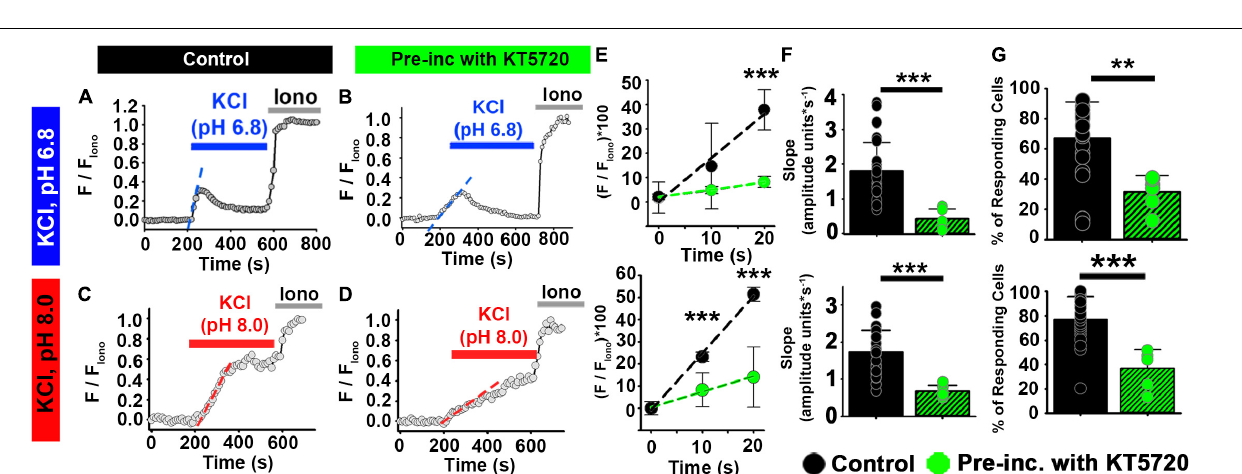
FIGURE 5 | PKA inhibition impairs the effect of HCO 3 − on depolarization-evoked Ca 2 + responses in ejaculated mouse sperm. (A–D) Representative traces of [Ca 2 + ] i responses to 50 mM KCl at pH 7.4 and pH 8.6 in ejaculated mouse sperm in (A,C) control conditions and (B,D) after pre-incubation with 10 µ M PKI. (E) Linear fit of the averaged normalized fluorescence in the first 20 s after KCl addition. (F) Graph of slope values of the best-fit regression line for each condition. Mean values at pH 7.4 were as follows: control, 2.20 ± 0.494 amplitude units * s − 1 (5 mice, 137 sperm); and PKI pre-incubation, 0.237 ± 0.144 amplitude units *s − 1 (4 mice, 86 sperm). Mean values at pH 8.6 were as follows: control, 2.45 ± 1.161 amplitude units * s − 1 (5 mice, 107 sperm); and PKI pre-incubation, 0.753 ± 0.232 amplitude units *s − 1 (3 mice, 81 sperm). (G) Graph of the percentage of responsive sperm. Mean values at pH 7.4 were as follows: control, 41.92% ± 10.22 (5 mice, 137 sperm); and PKI pre-incubation, 16.30% ± 7.01 (4 mice, 82 sperm). Mean values at pH 8.6 were as follows: control, 70.96% ± 11.50 (5 mice, 107 sperm); and PKI pre-incubation, 31.22% ± 22.80 (3 mice, 81 sperm). * P < 0.050, ** P < 0.010, and *** P < 0.001 by independent t -test. Error bars indicate standard deviation. Iono = 5 µ M Ionomycin + 2 mM Ca 2 + .